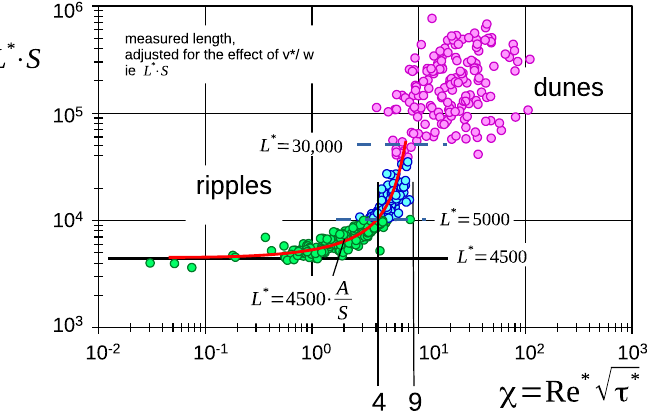
Figure 13. Dimensionless length of ripples and dunes, L (cid:63) , as well as their subdivision according to boundary layer instabilities. The data are adjusted for the suspension effect. The ripples, dominated by the acceleration effect are colored in blue. Red curve: Equation (34). For data source, see Section 2.